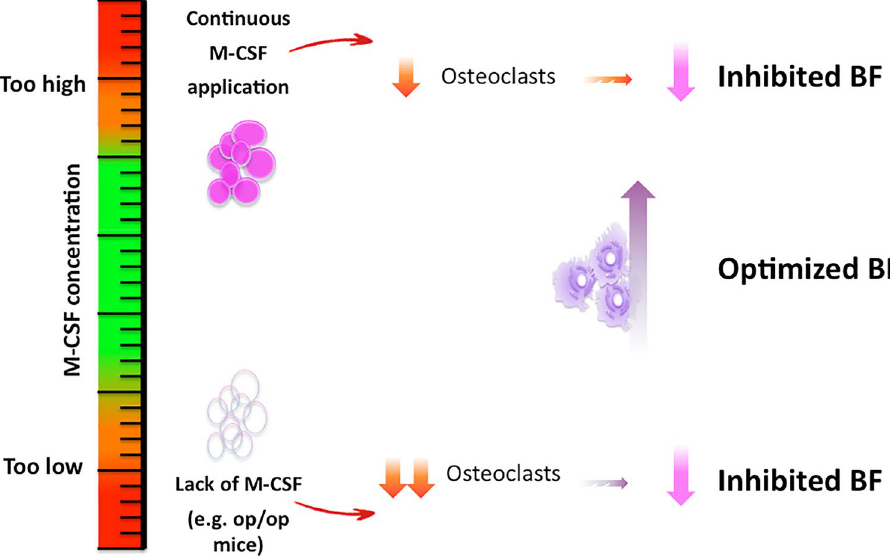
Figure 7. Systemic M-CSF concentration is crucial for it’s effect on osteoclasts and any downstream mechanism. M-CSF macrophage colony-stimulating factor, op/op osteopetrosis knock out mice, BF bone